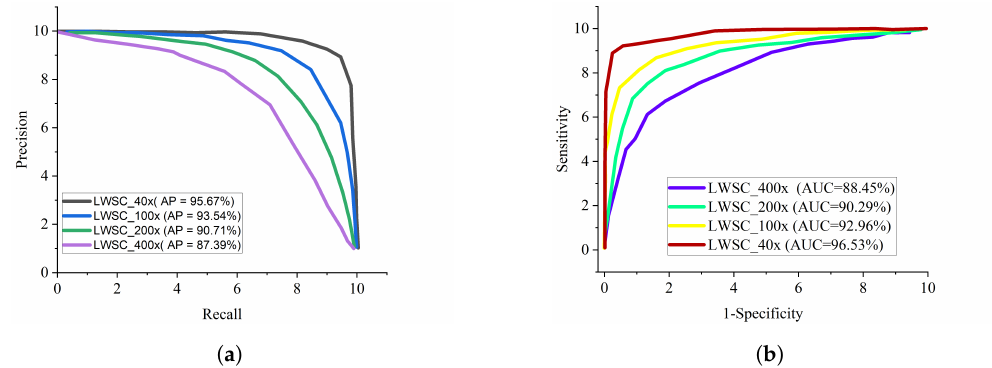
Figure 6. Comparison report of the BC classification for eight classes. ( a ) Precision–recall curve for different magnification factors for eight classes BC classification; ( b ) ROC curve for different magnification factors for eight classes BC